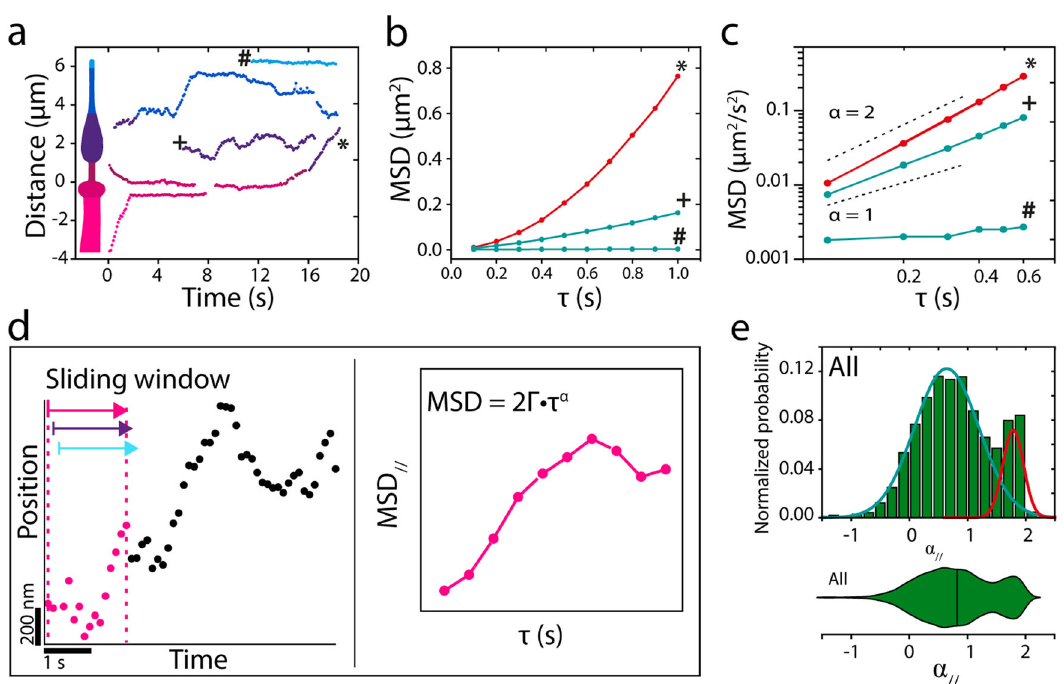
Fig. 3 Analysis of single-molecule OCR-2 trajectories. a Example single-particle trajectories from the kymographs of Fig. 2a. b Mean squared displacement (MSD) of annotated trajectories in a , demonstrating active transport (*), normal diffusion ( + ), and subdiffusion (#). c Log – log plot of the fi rst six time points. d Cartoon explaining the single-molecule data analysis with a sliding window. e Histogram and corresponding violin plot of normalized probability of α // for all 7237 data points obtained from 23 nematodes. Colored lines represent two underlying Gaussian